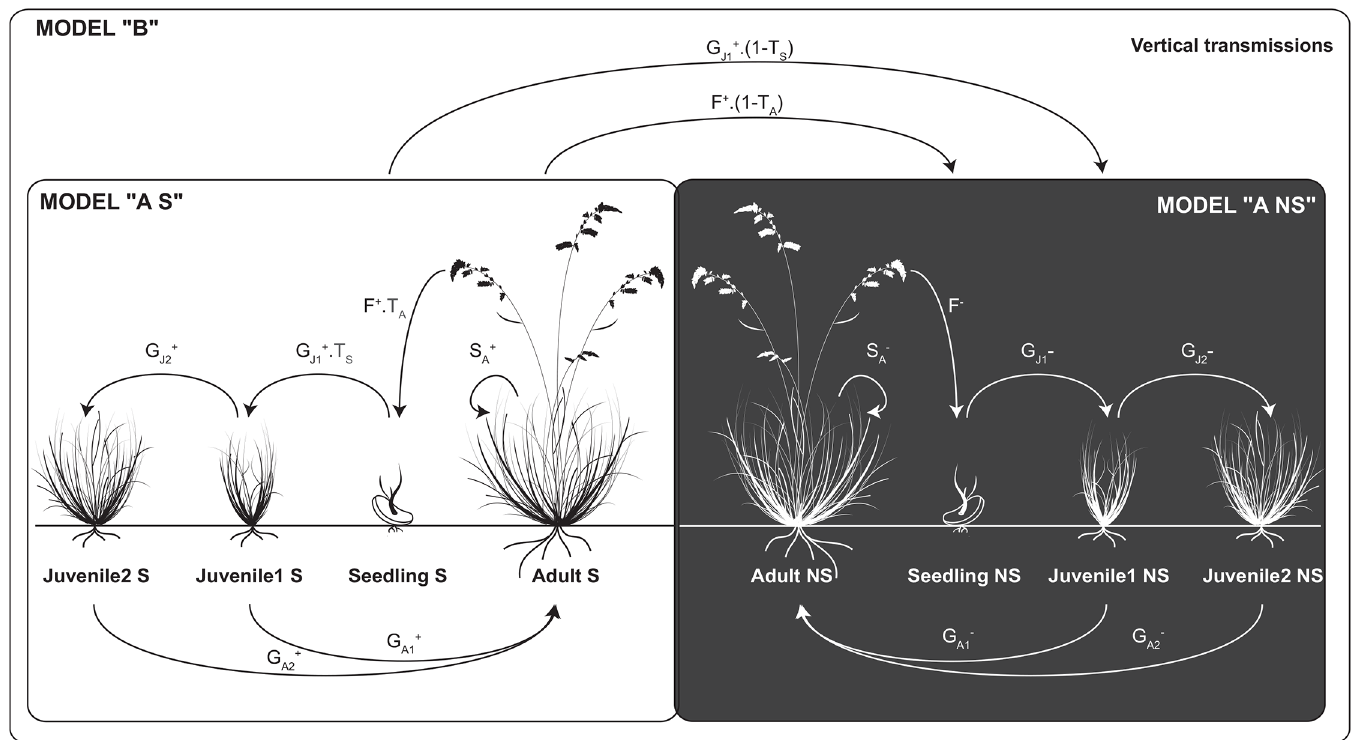
Fig 1. Diagram of the life cycle model for Festuca eskia populations including symbiotic and non-symbiotic plants. The model can be broken down into three submodels, according to the endophytic status of the plants present in the population: A S , A NS and B. Globally, the model includes four symbiotic stages (Seedling S, Juvenile 1 S, Juvenile 2 S, Adult S), four non-symbiotic stages (Seedling NS, Juvenile 1 NS, Juvenile 2 NS and Adult NS), two probabilities for transitions between S and NS stages (Vertical transmissions: T S from seedling S to Juvenile 1 NS; T A from adult S to seed NS,), two fecundity arcs (F + and F - ), two survival probabilities (S A+ and S A- ) and eight growth transitions (G J1+ , G J1- , G J2+ , G J2- , G A1+ ,G A1- ,G A2+ , G A2-